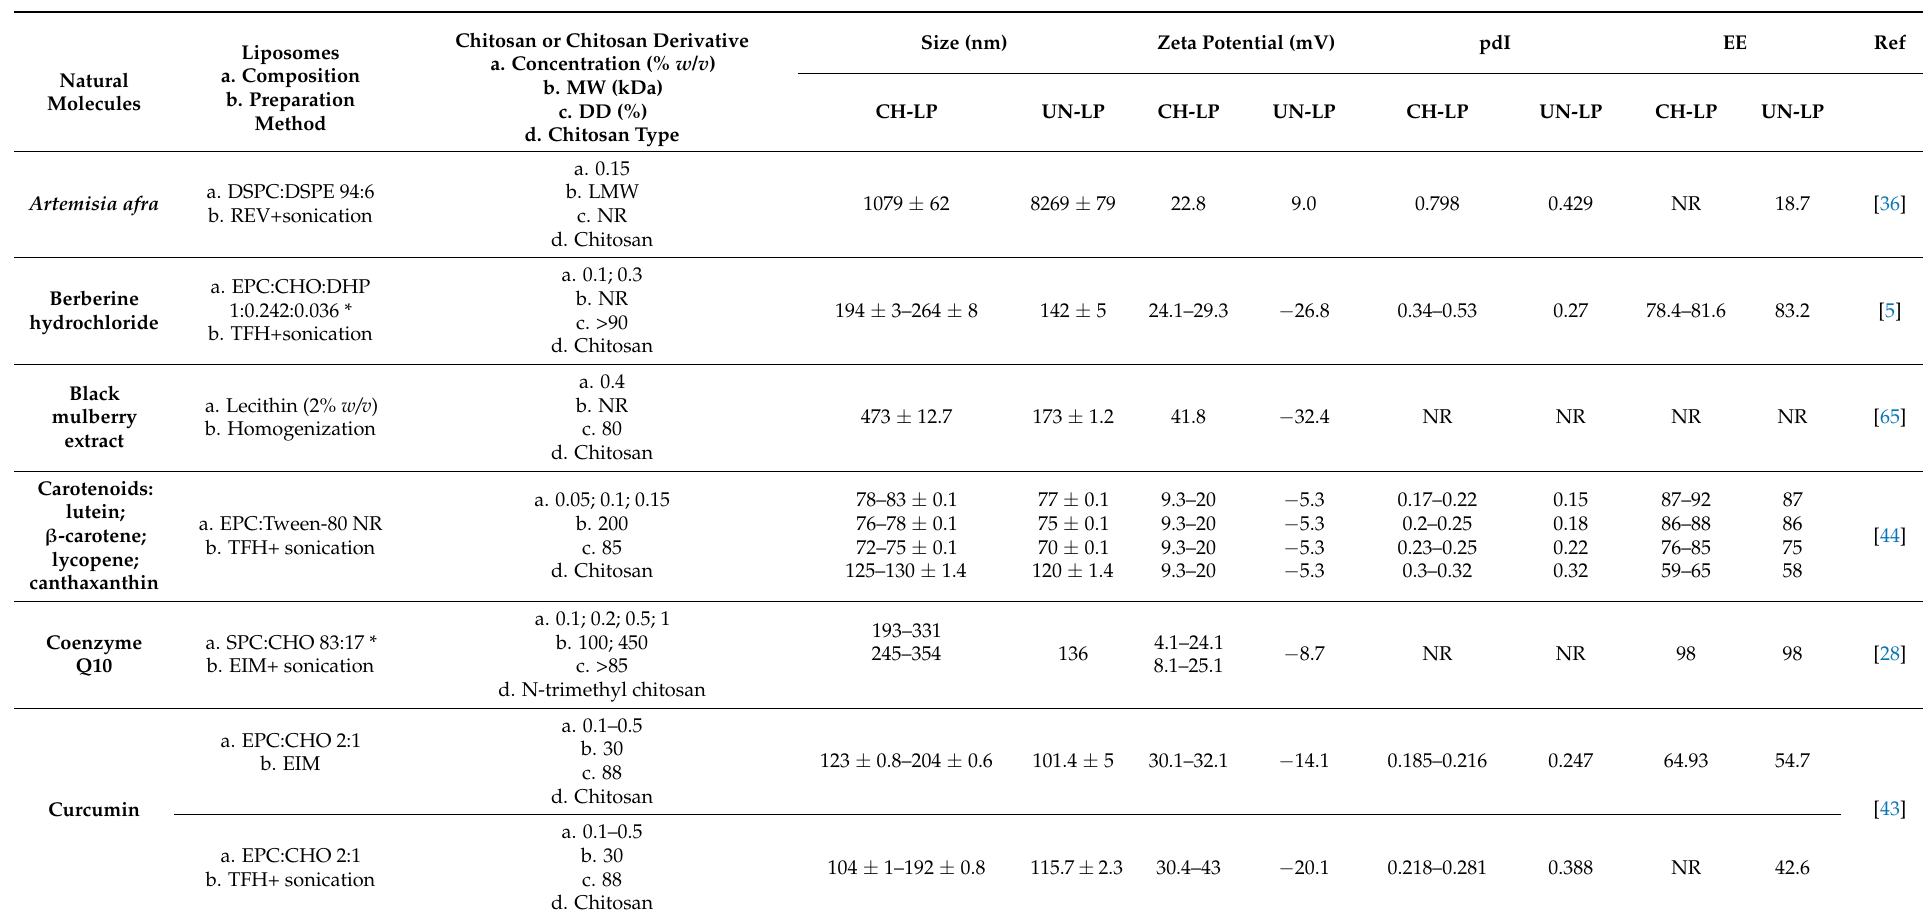
Table 2. Comparison of size, surface charge, homogeneity and drug encapsulation efficiency (EE) between liposomes and chitosomes loading natural bioactive molecules. The liposomal composition is indicated in the table in molar ratio except when * exists, indicating a weight ratio ( w/w